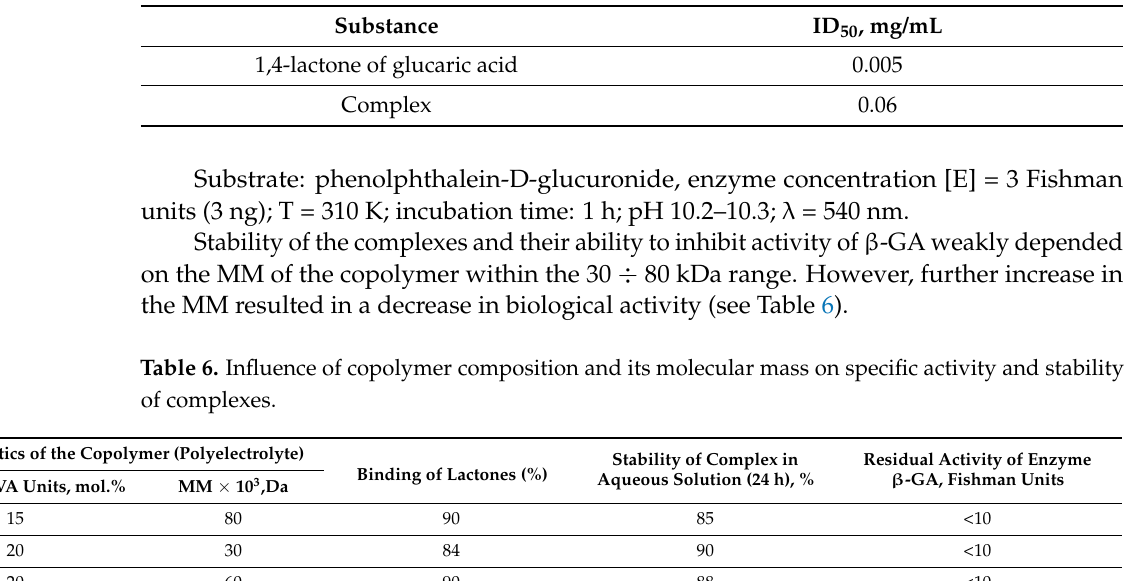
Table 5. ID 50 of complex and 1,4-GL.